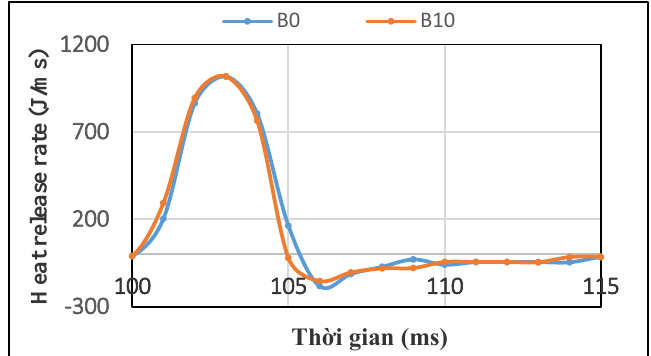
Figure 14. Evolution of the exothermic rate of the test fuel.